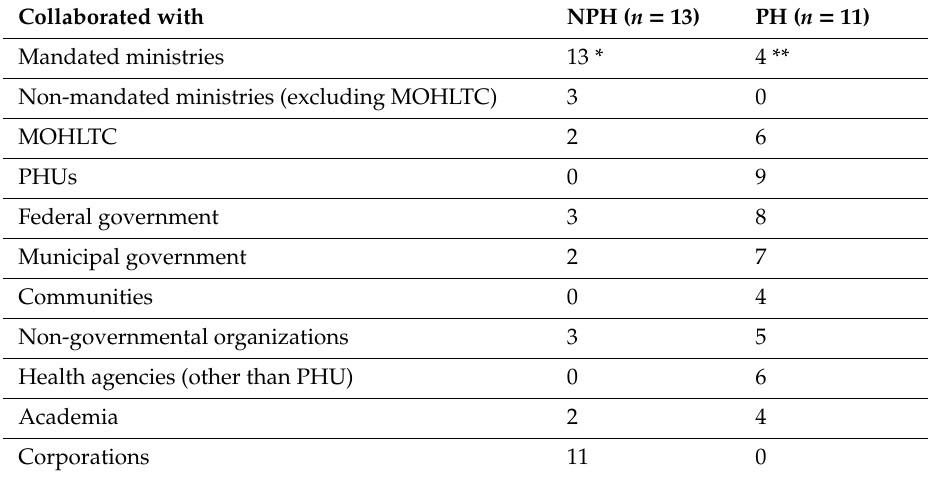
Table 4. Summary of stakeholder included in climate policy deliberations Collaborated